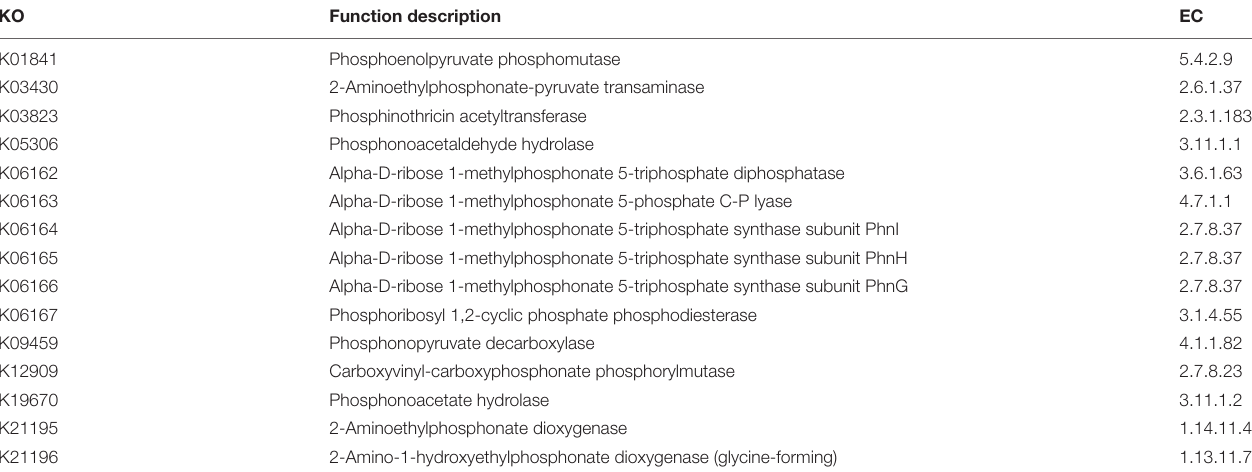
FIGURE 4 | The LEFSe cladogram of fungal communities (containing phosphate-solubilizing fungi) after DFAA/natural rainfall. TABLE 1 | The Kyoto Encyclopedia of Genes and Genomes Orthology (KEGG) Orthology related to phosphorus metabolism in topsoil layer (0–40 cm). KO Function